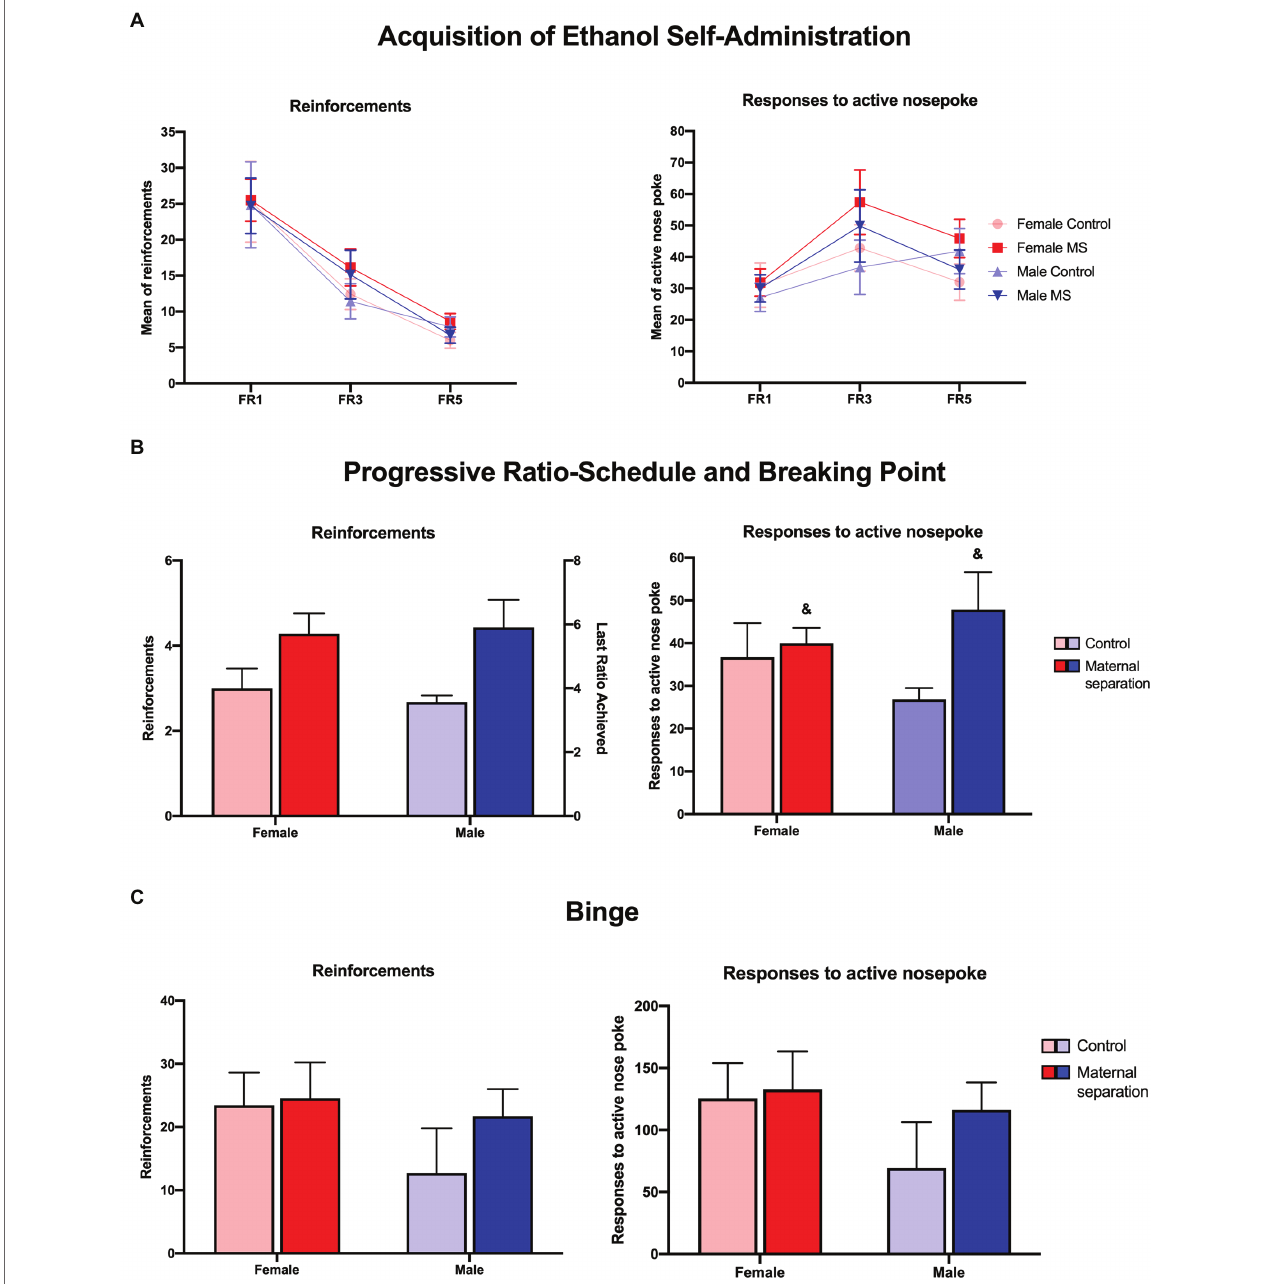
FIGURE 3 | Operant self-administration protocol. (A) Means of reinforcements and responses to active nose poke of female and male mice submitted to MS and control group during FR1, FR3, and FR5 schedules of acquisition self-administration phase. (B) Means of reinforcements and highest completed ratio, mean of responses to active nose poke of female and male mice submitted to MS and control group during PR schedule. & MS stress > control, considering stress factor. (C) Means of reinforcements and mean of responses to active nose poke, of female and male mice submitted to MS and control group in Binge protocol. N = 28 (Control: n = 14; female = 7, male = 7, MS: n = 14; female = 7, male = 7). LMM and generalized linear model (GLM) analysis, data: mean ±